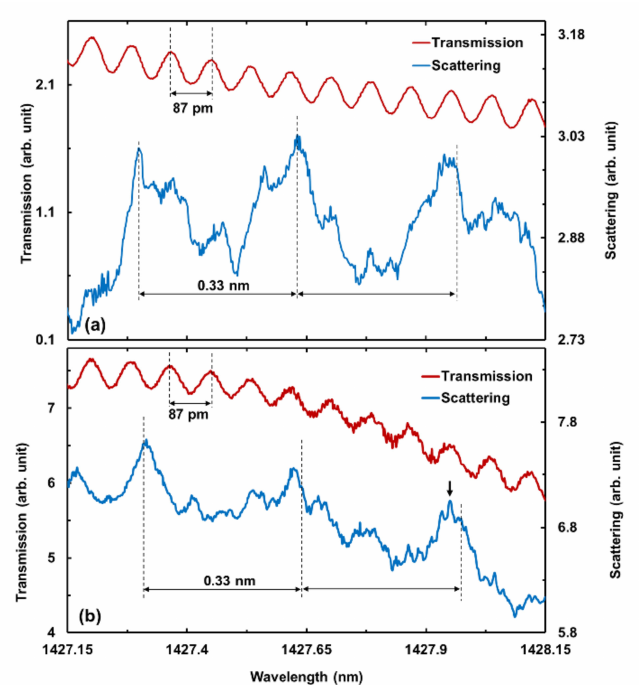
Figure 4. ( a ) Transverse electric (TE)- and ( b ) transverse magnetically (TM)-polarized measurement of 90 ◦ elastic scattering and 0 ◦ transmission spectrum of diamond sphere on diamond waveguide in the near-infrared telecommunication spectral region. The black arrow indicates the highest Q-factor resonance